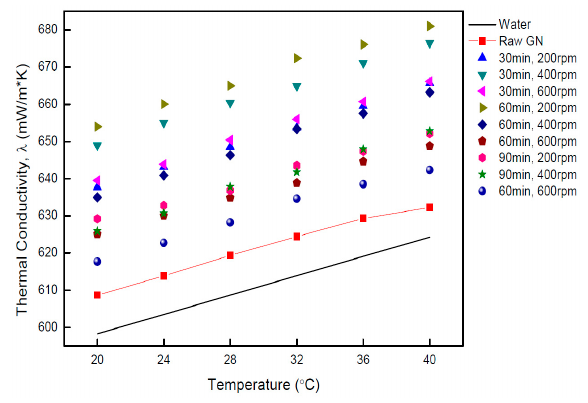
Figure 5. The thermal conductivity of GN solutions prepared by various parameter.